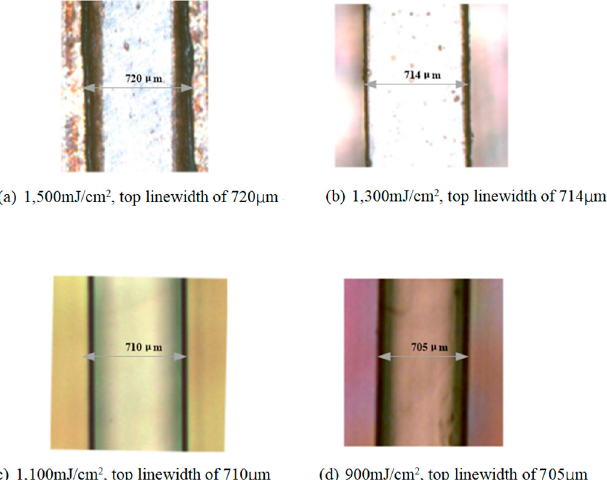
Figure 6. SU-8 resist patterns obtained by various exposure dosages and corresponding top linewidth.